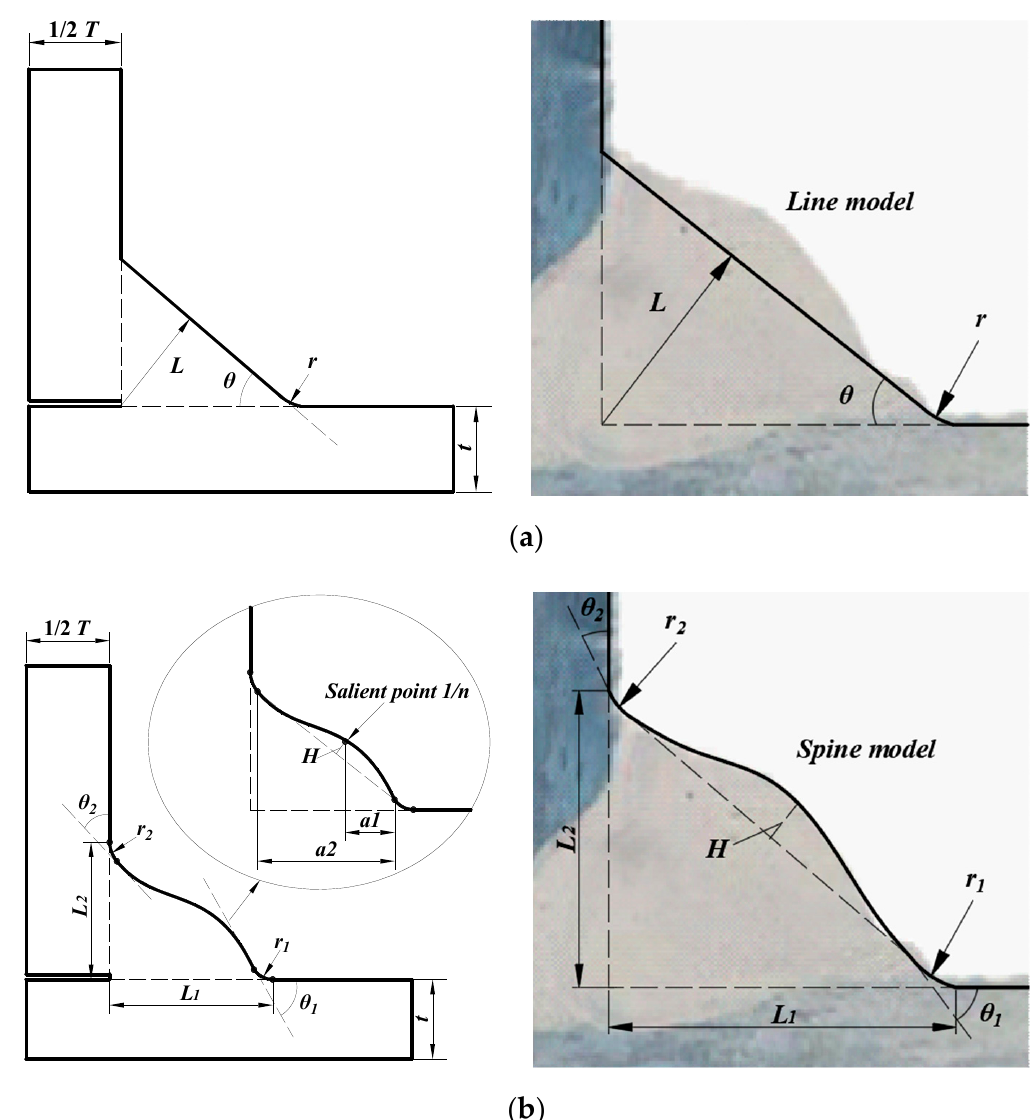
Figure 1. Fillet weld model (T-shape joint): ( a ) line model; ( b ) spline model. A spline model which considered the shape of butt weld joints was suggested by Luo